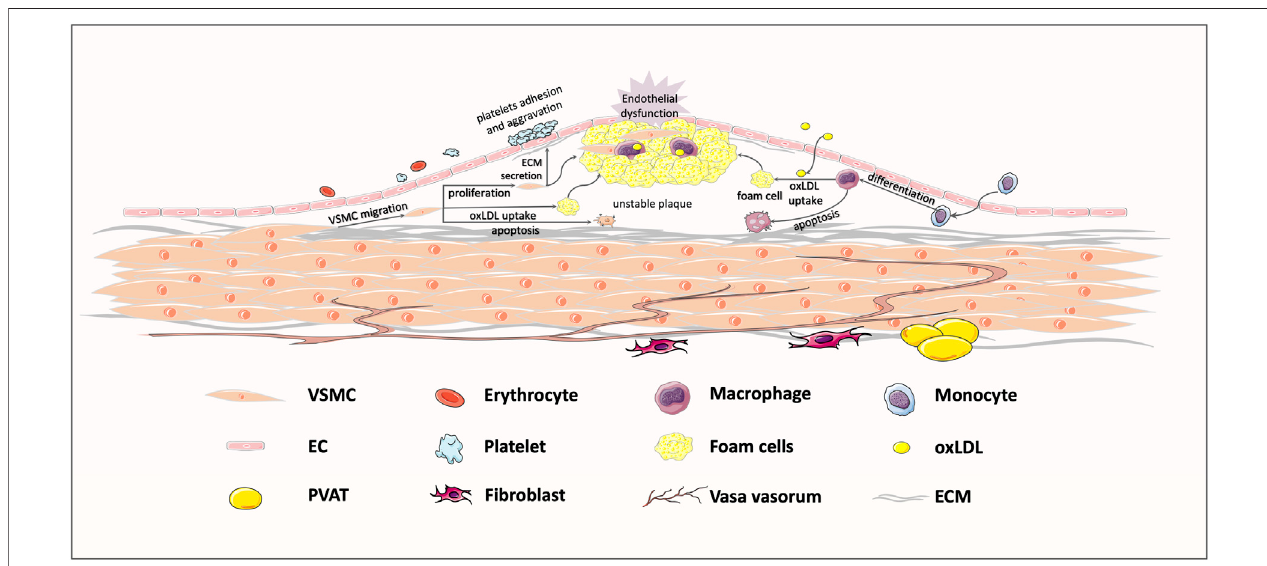
FIGURE 1 | Typical response to vessel injury, in an atherosclerosis example. Exposure to some risk factors, like hypertension, hyperglycemia, and hyperlipemia, might bring about endothelial injury and subsequent lipoprotein in fi ltration. The in fi ltrating low-density lipoprotein (LDL) is oxidized to oxLDL, which could be recognized by transmembrane receptors. Then, macrophages and VSMCs migrate to the intima to take up oxLDL, shifting the cell phenotype to foam cells. Foam cell recruitment and vascular smooth muscle cells (VSMCs) proliferation jointly contribute to the formation of unstable plaques, ultimately leading to vessel stenosis.